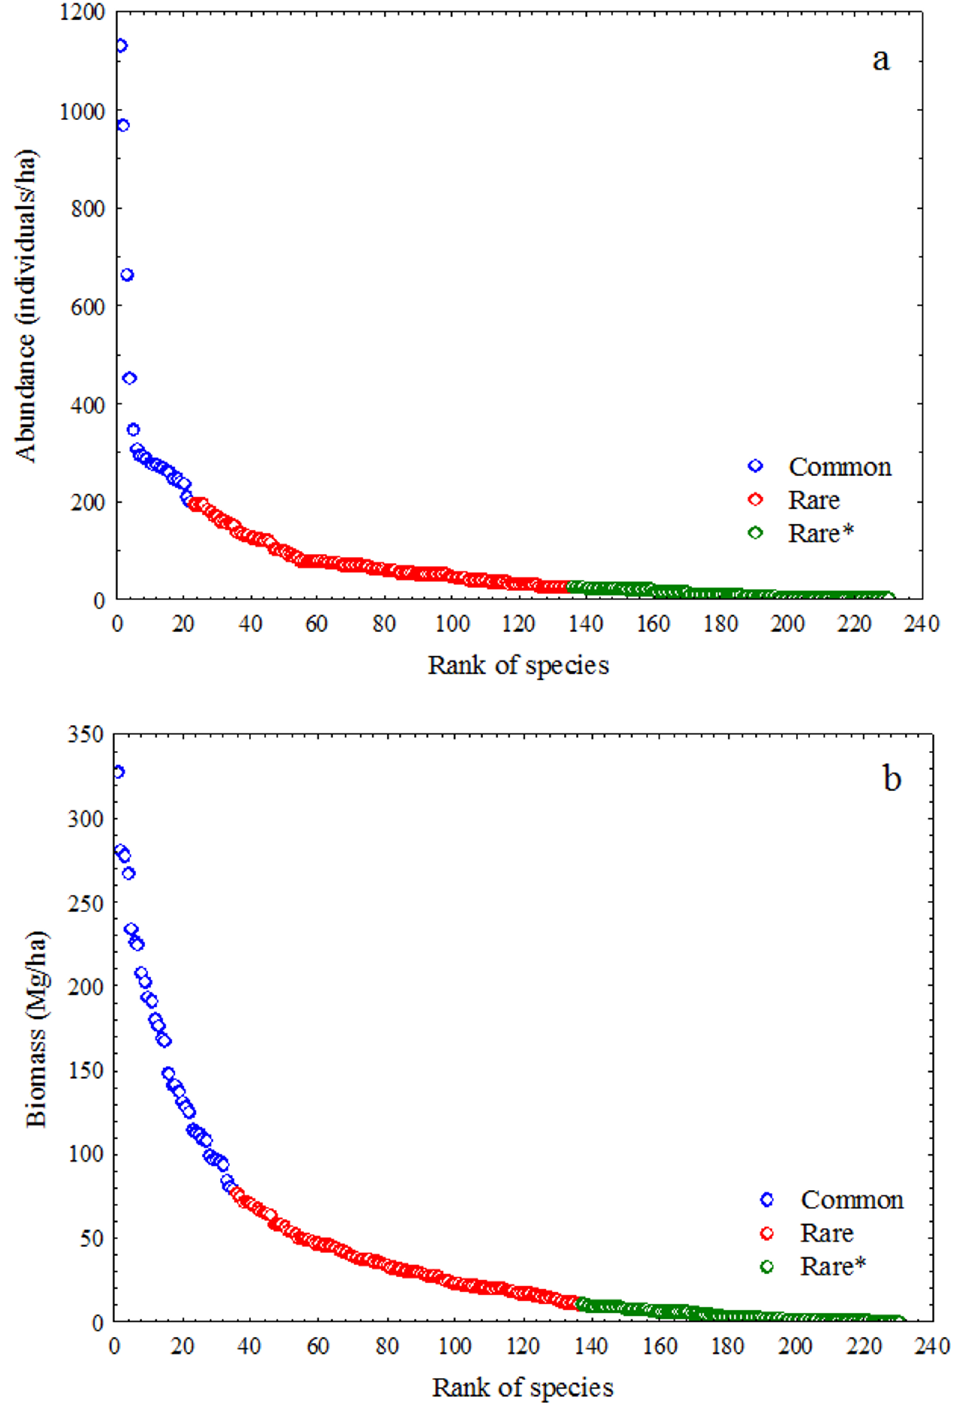
Fig 2. Rank of abundance (a) and rank of biomass (b) of Amazonian tree species of a metacommunity in the Tapajo ´ s National Forest, Para ´ State, Brazil. * indicatesthe rare species with the same information content as common